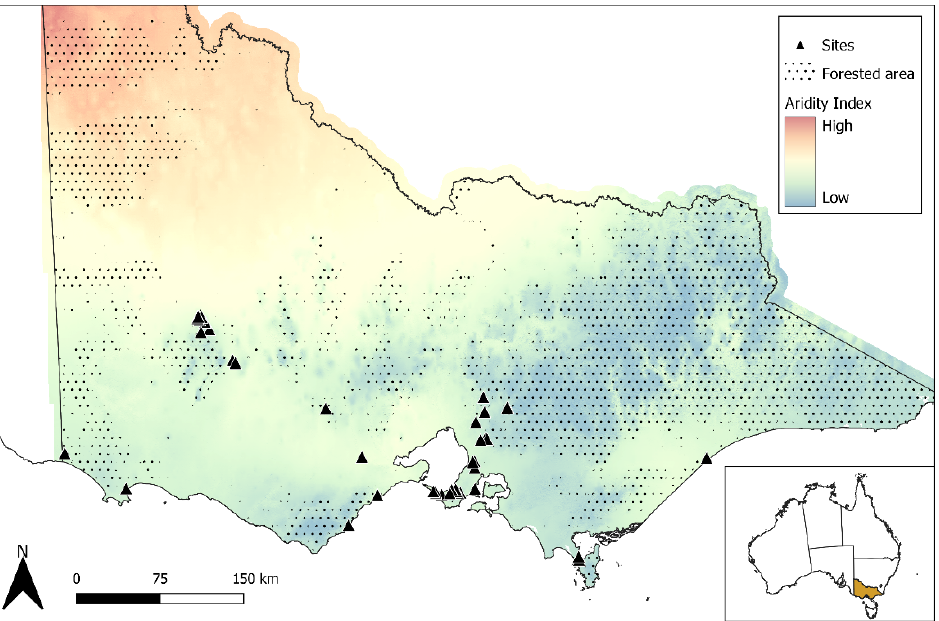
Figure 1. Locations of masticated study sites across Victoria, south-eastern Australia. Aridity index [30] is depicted on a colour scale with the most arid areas in red and least arid areas in blue. Forested area in Victoria is depicted with dots.